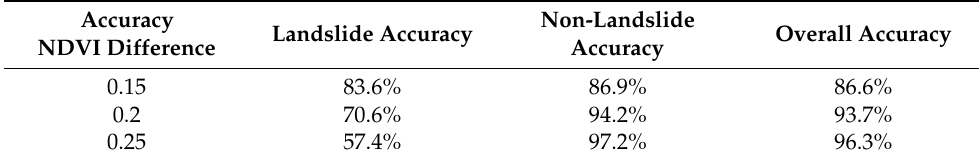
Table 6. Overlapping results, Typhoon Haitang and the 2005 Landslide Catalogue.